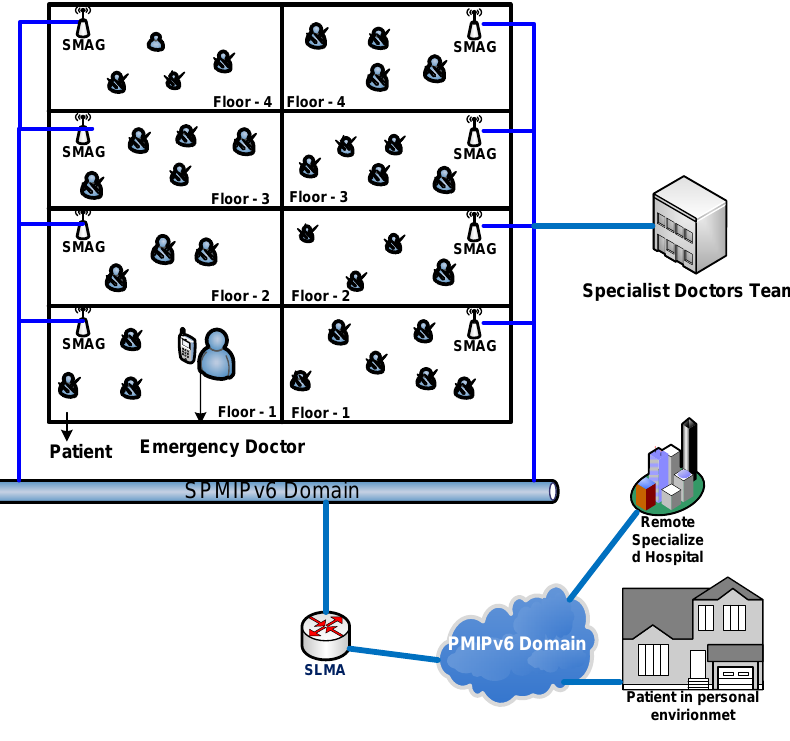
Figure 3. Mobility scenario in SPMIPv6-based patient care